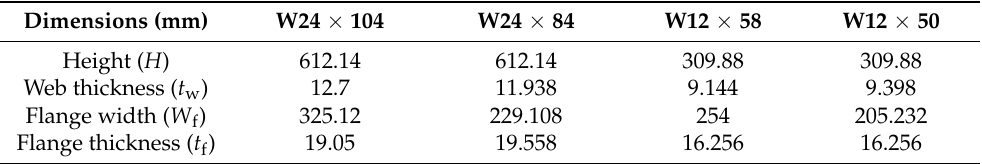
Table 2. Dimensions of the analyzed standard steel beams.